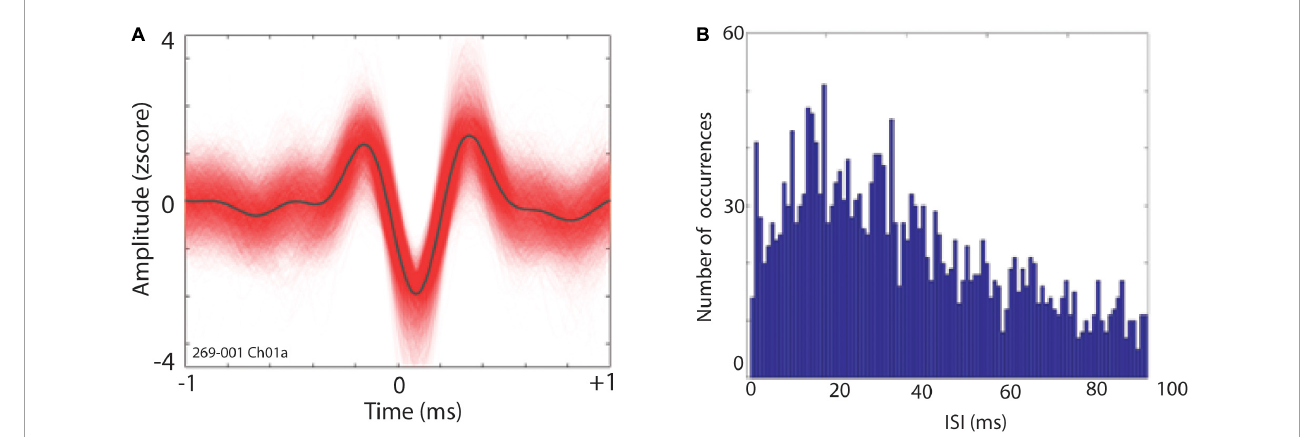
FIGURE2 (A) Exemplar waveforms of a putative STN single neuron. (B) Distribution of interspike intervals (ISI) for single unit depicted in panel (A) .